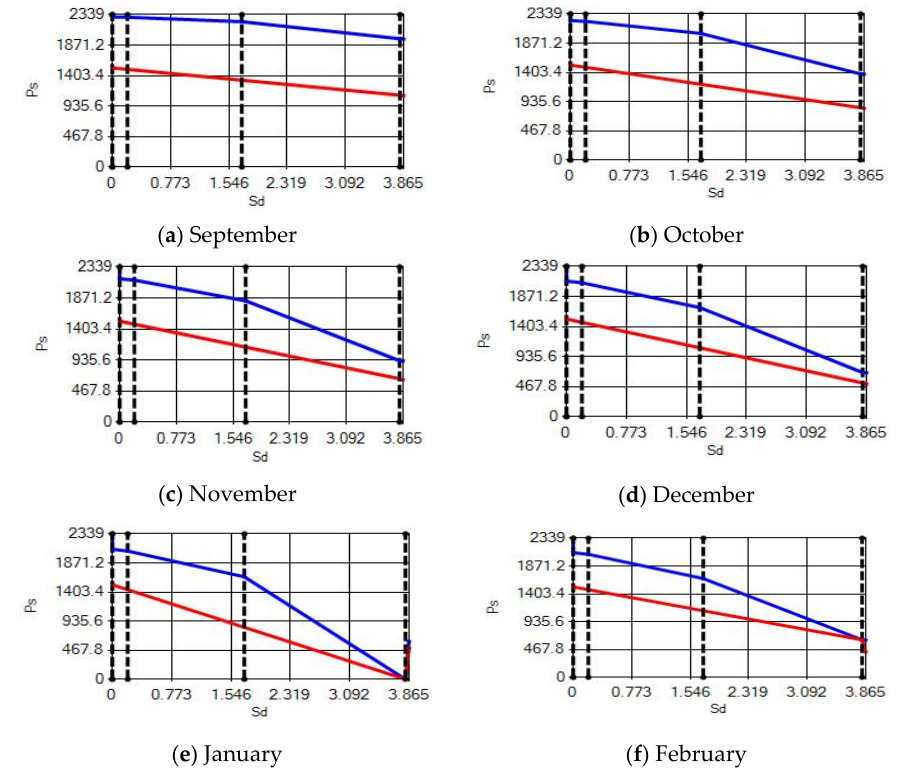
Figure 20. Condensation and evaporation amount chart in the building elements of the brick external wall for the 3rd zone for ( a ) September, ( b ) October, ( c ) November, ( d ) December, ( e ) January and ( f ) February.